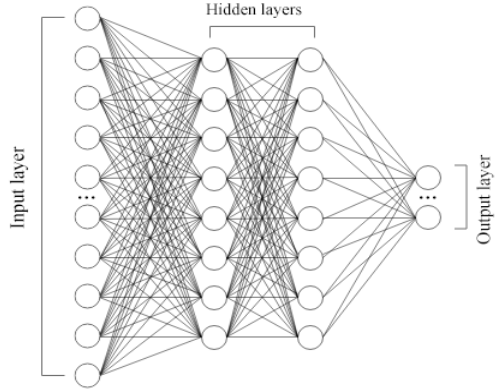
Figure 4. ANN with fully connected layers. Multiple configurations were tested with and without dropout layers to combat overfiting [25]. A single layer with 512 neurons (reported as “Dense” in results) and no dropout layers provided the best results for both the price and load